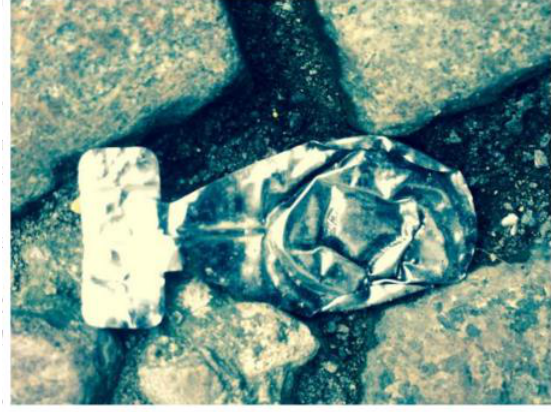
Figure 15. Heroin spoon on Car Park